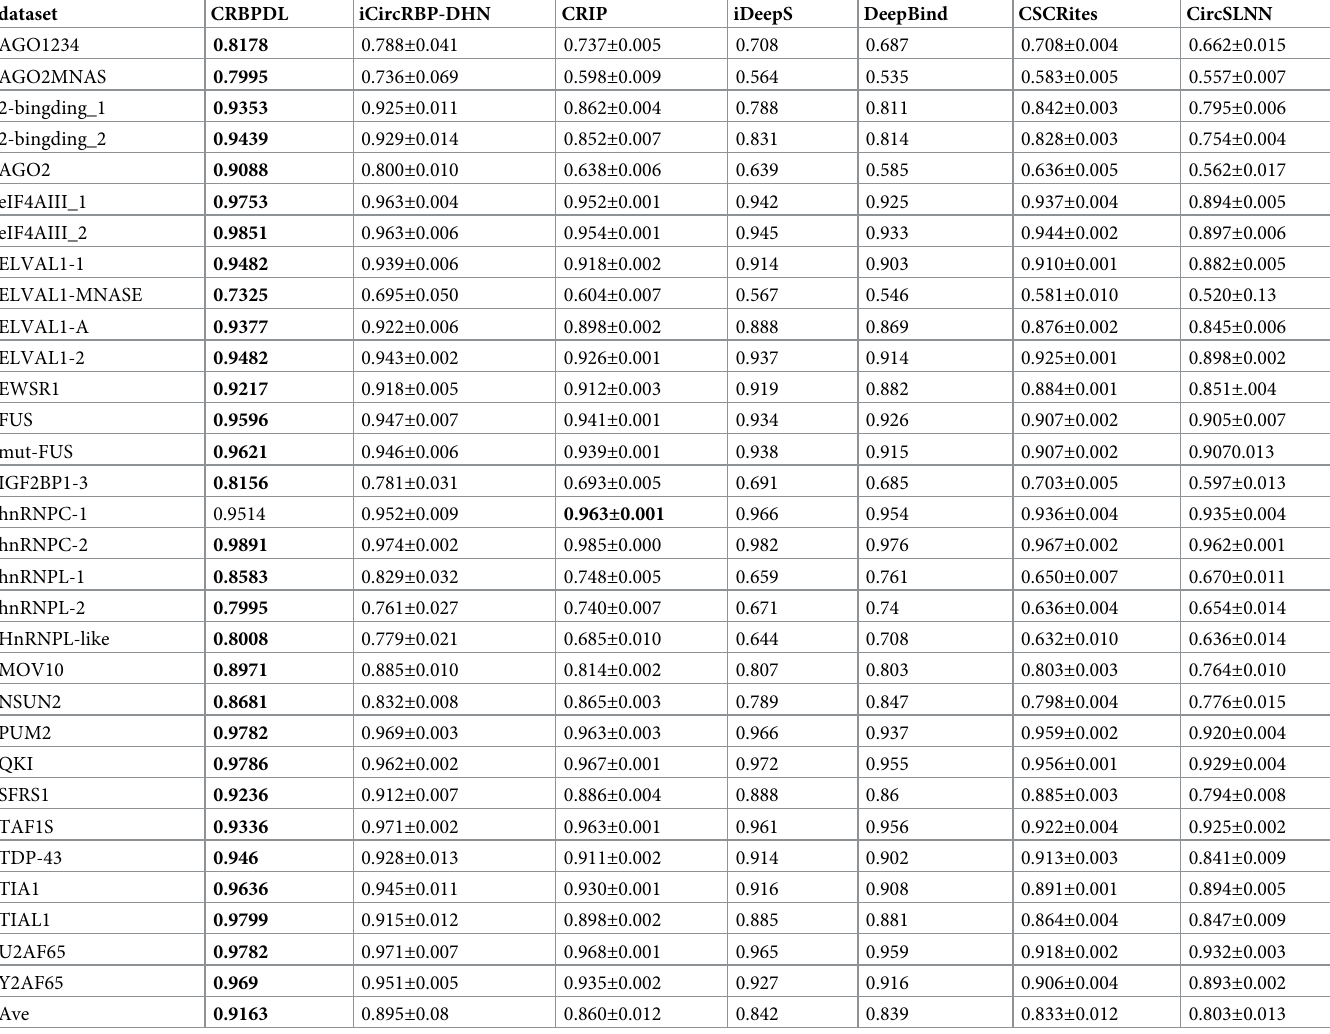
Table 2. Comparison of prediction performance under different classification models on 31 linear RNA